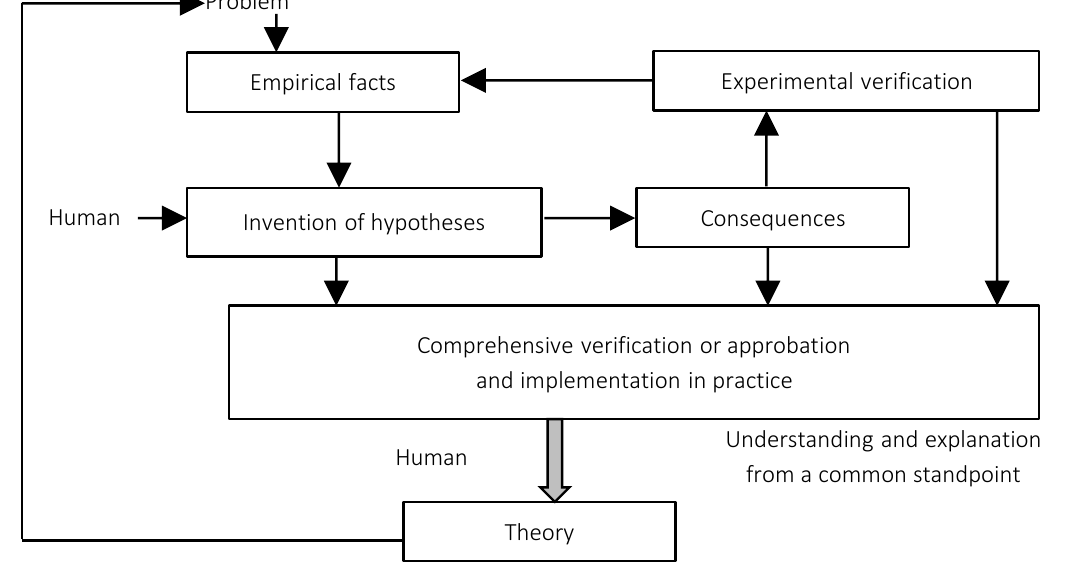
Figure 1. General scheme of cognition